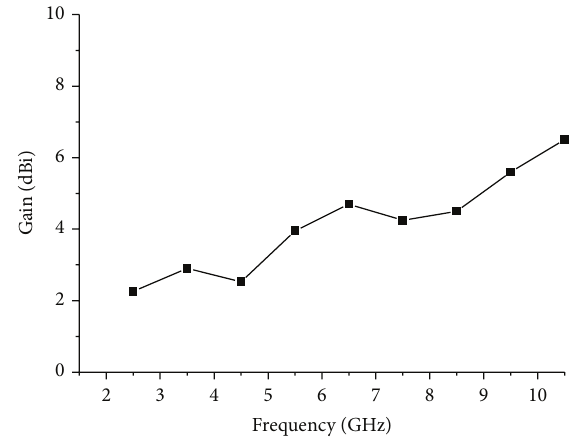
Figure 8: Gains of the optimal antenna.